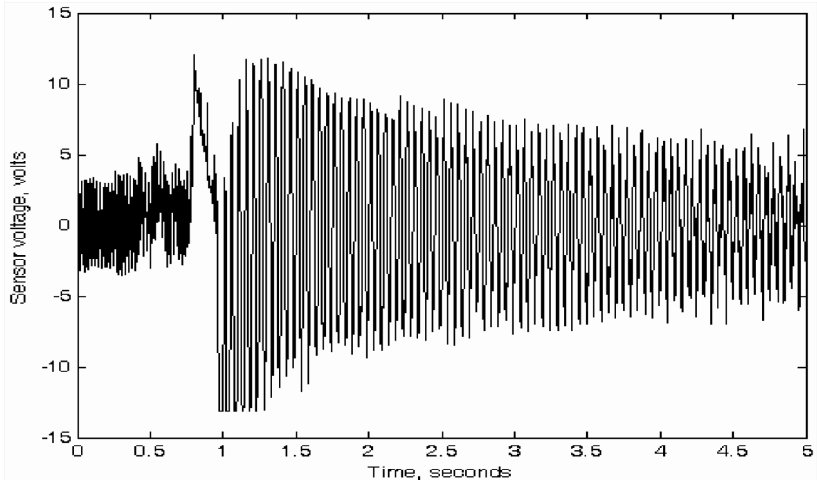
Fig. 10. SMC of plate without boundary